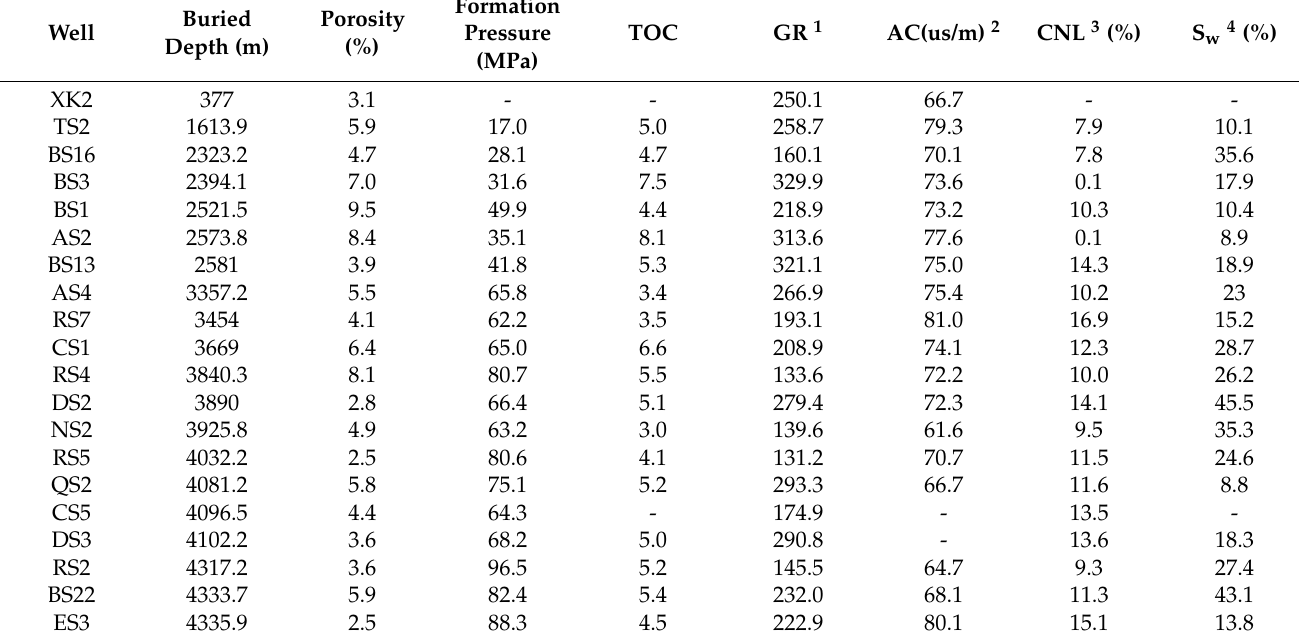
Table 1. Basic reservoir parameters and logging parameters of the samples.